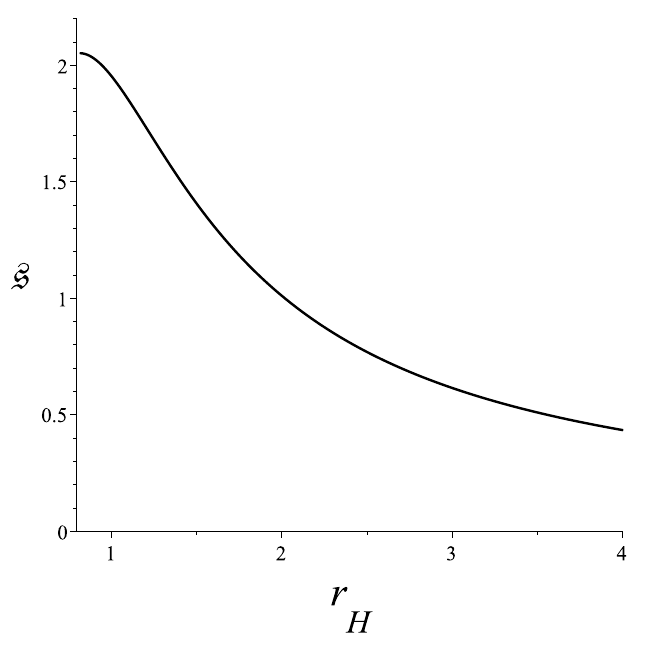
Figure 5 . Specific entropy of a “large” AdS 5 -Reissner-Nordström black hole with temperature approximately 1% higher than the minimal possible temperature of an AdS 5 -Schwarzschild black hole, using units in which L = 1. On the physical domain (to the right of the radius of the AdS 5 - Schwarzschild black hole of that temperature) the function is